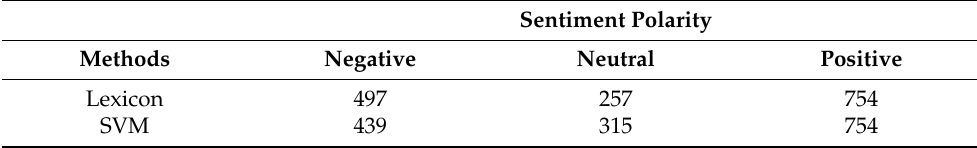
Table 6. Sentiment polarity scores between lexicon and machine learning classification.